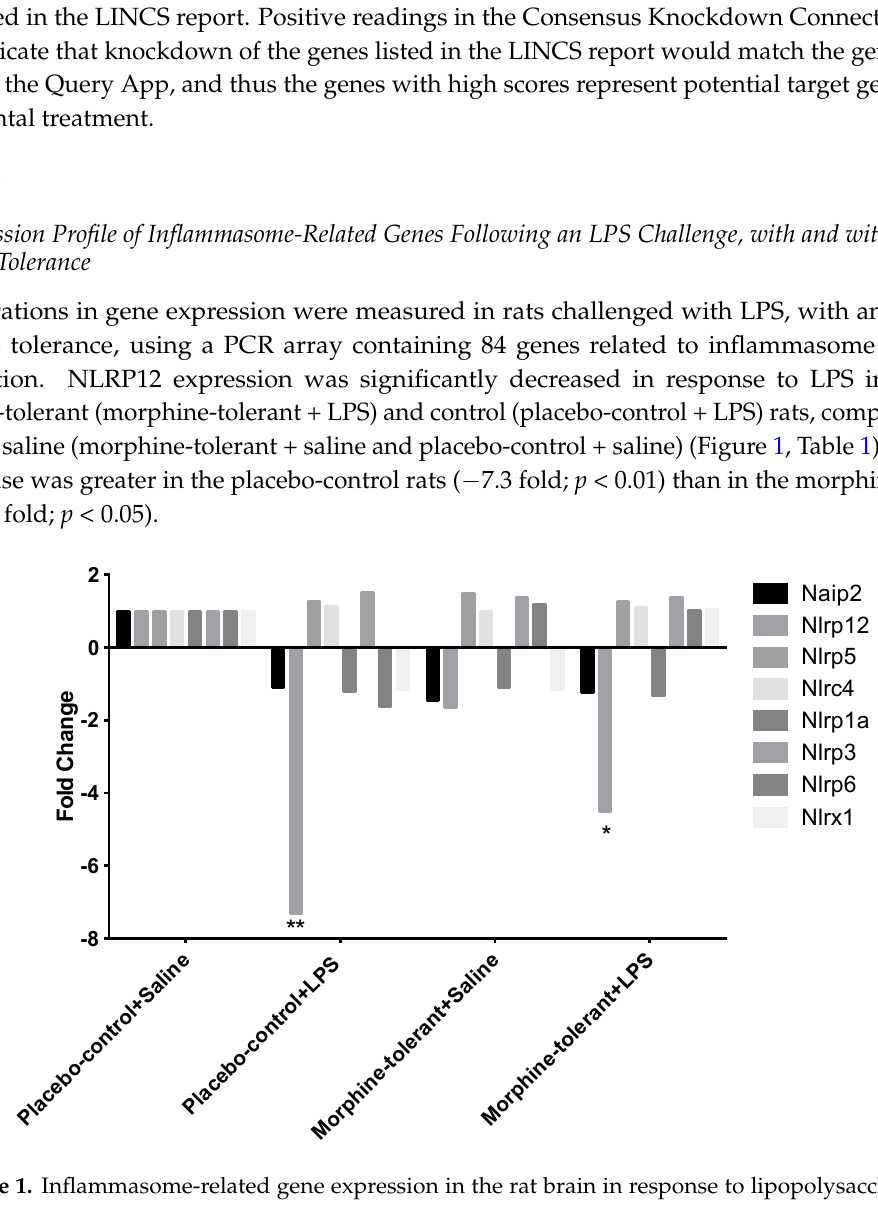
Figure 1. Inflammasome-related gene expression in the rat brain in response to lipopolysaccharide (LPS), with and without morphine tolerance. The expression of the inflammasome-related NOD-like receptor (NLR) genes (Naip2, Nlrp12, Nlrp5, Nlrc4, Nlrp1a, Nlrp3, Nlrp6, And Nlrx1) in the brains of rats given an i.p. injection of either 250 µg/kg LPS or saline, with and without morphine tolerance ( n = 3–5 rats per group), was determined using a PCR array. Data were calculated using the ΔΔ CT method, relative to the control group (placebo-control +saline), and are represented as a fold change. * p < 0.05, ** p < 0.01. Naip2: NLR family, apoptosis inhibitory protein 6; Nlrp12: NLR Family Pyrin